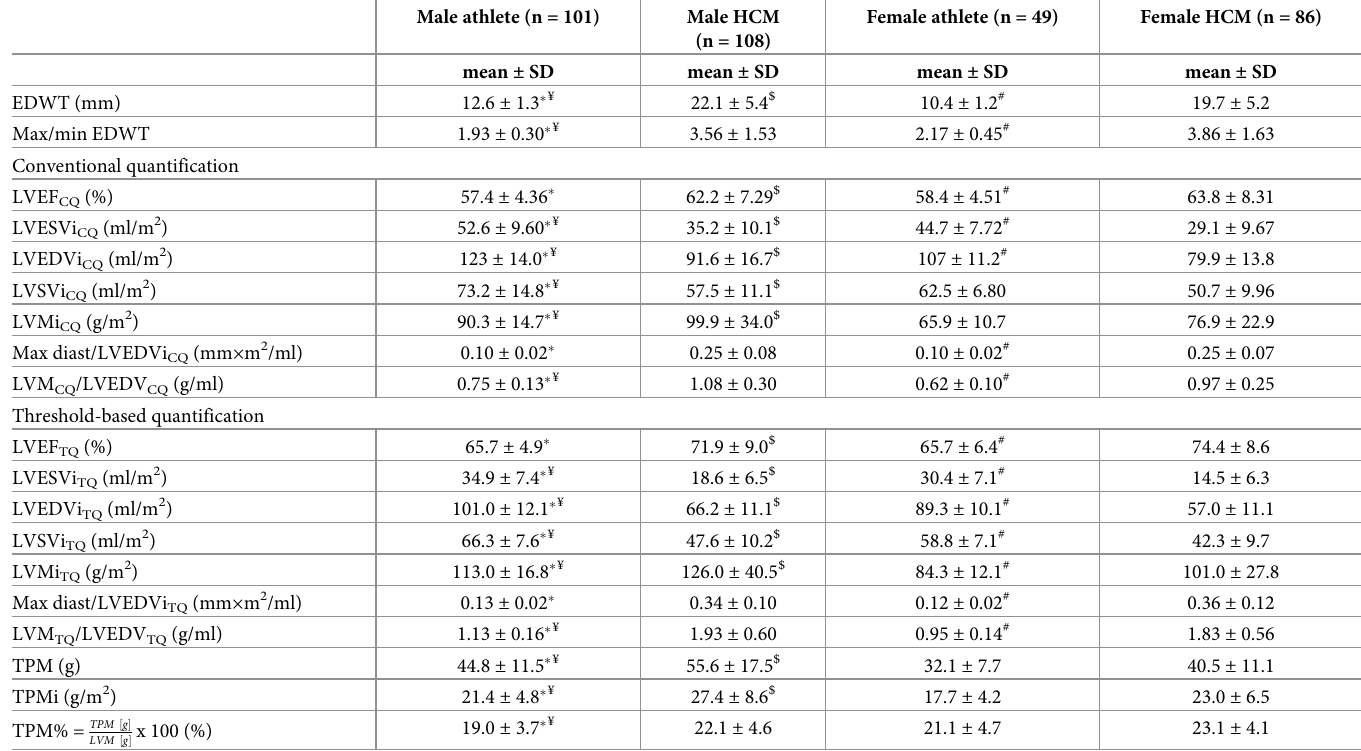
Table 2. Left ventricular CMR parameters in the four subgroups evaluated using conventional (CQ) and threshold-based (TQ) quantification.